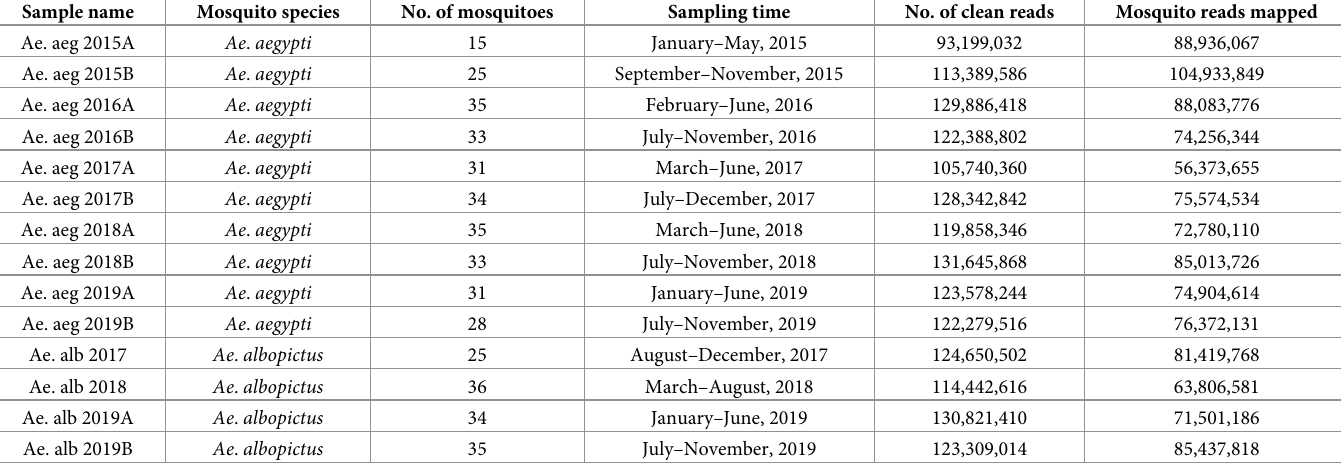
Table 1. Summary of the sequencing results showing data on pooled samples and the numbers of mosquitoes, mosquito species, read sequences, and mapped mos- quito